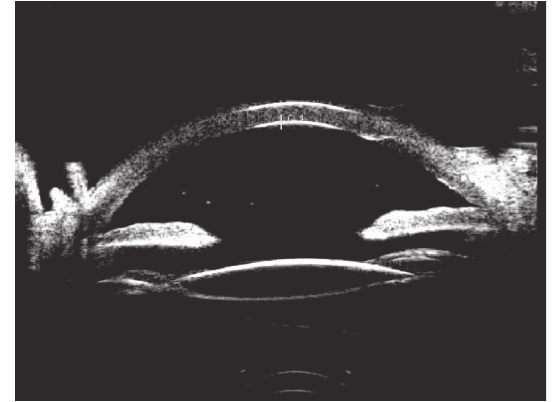
Figure 5: Postoperative ultrasound biomicroscopic image of the same patient as that in Figure 4.